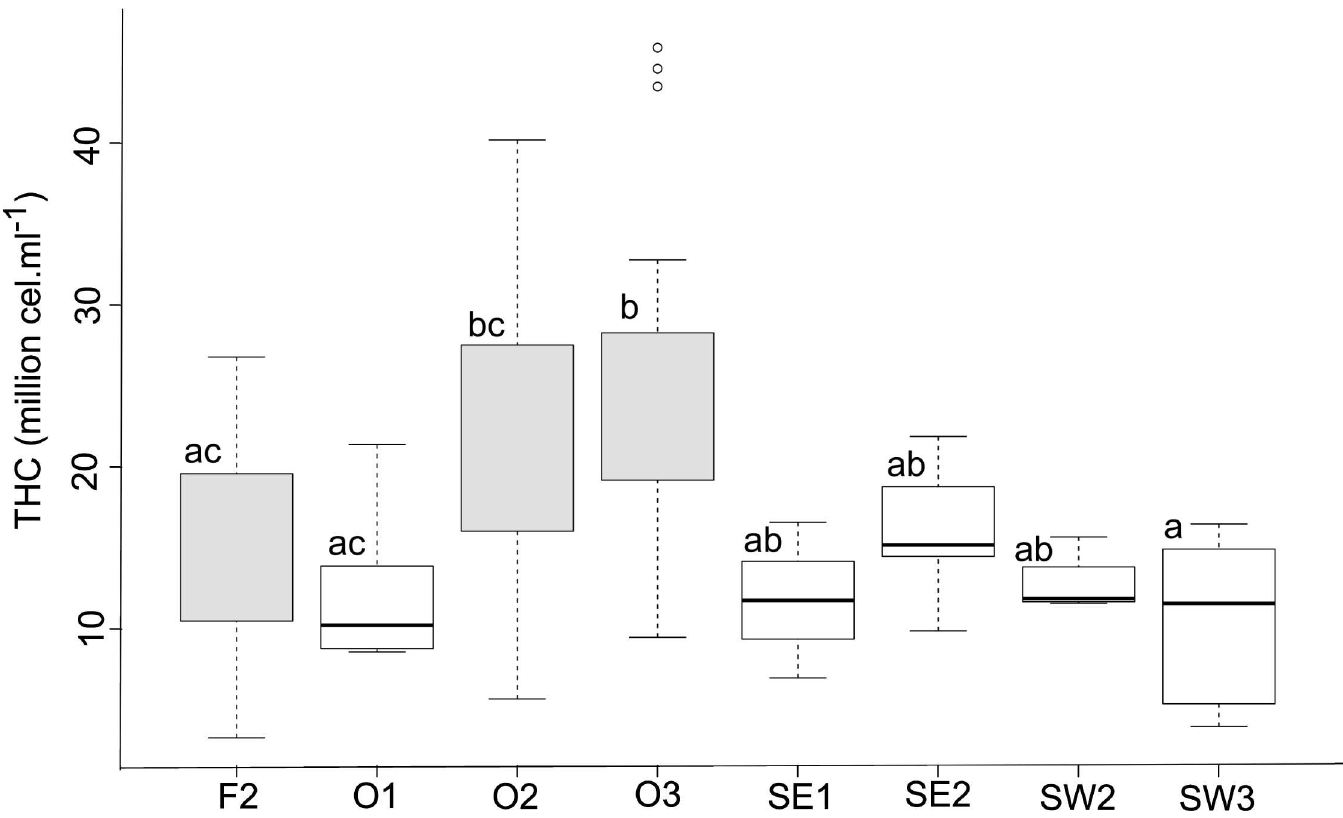
Fig 6. Boxplot of THC counts amongst sites around Tasmania. For explanation on boxplotsrefer to Fig 3. Different letters abovethe bars indicate significantdifferences betweensites. Grey boxes represent sites with red shallow water lobsters, while white boxes represent sites with brindledeep water